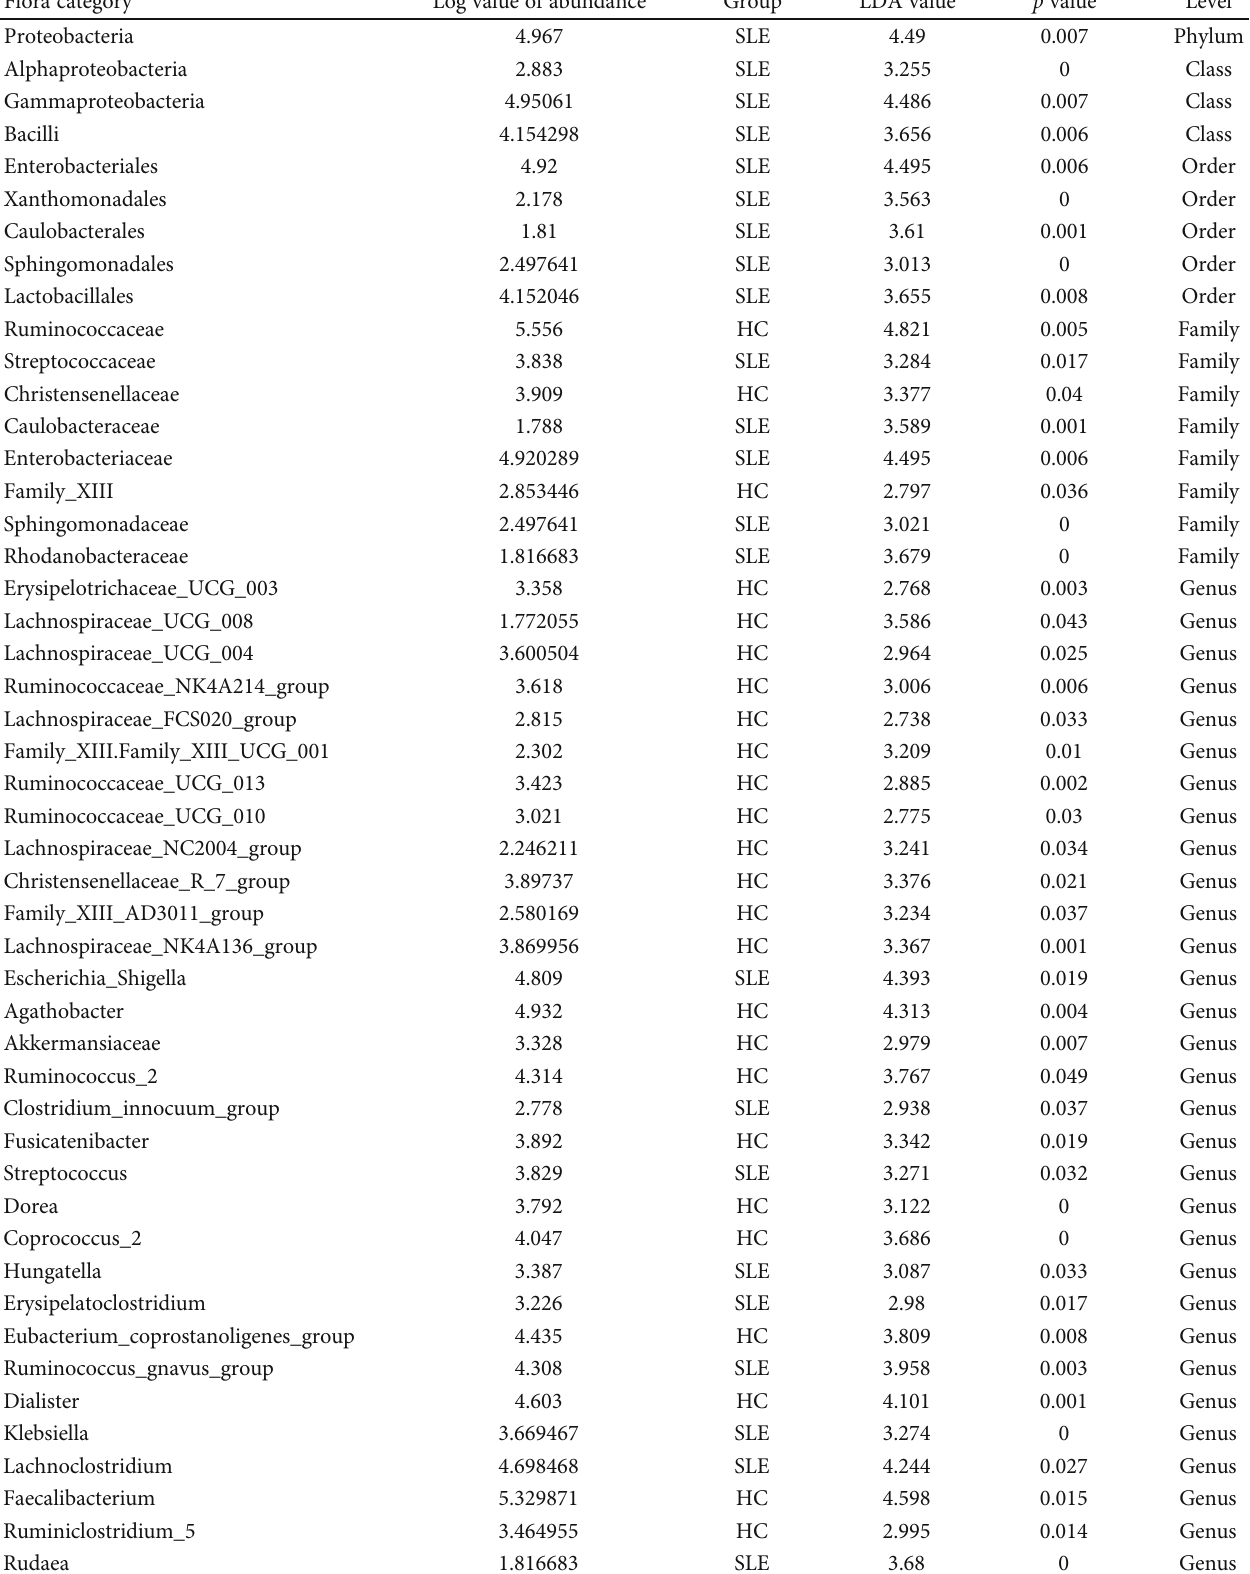
Table 2: Di ff erent